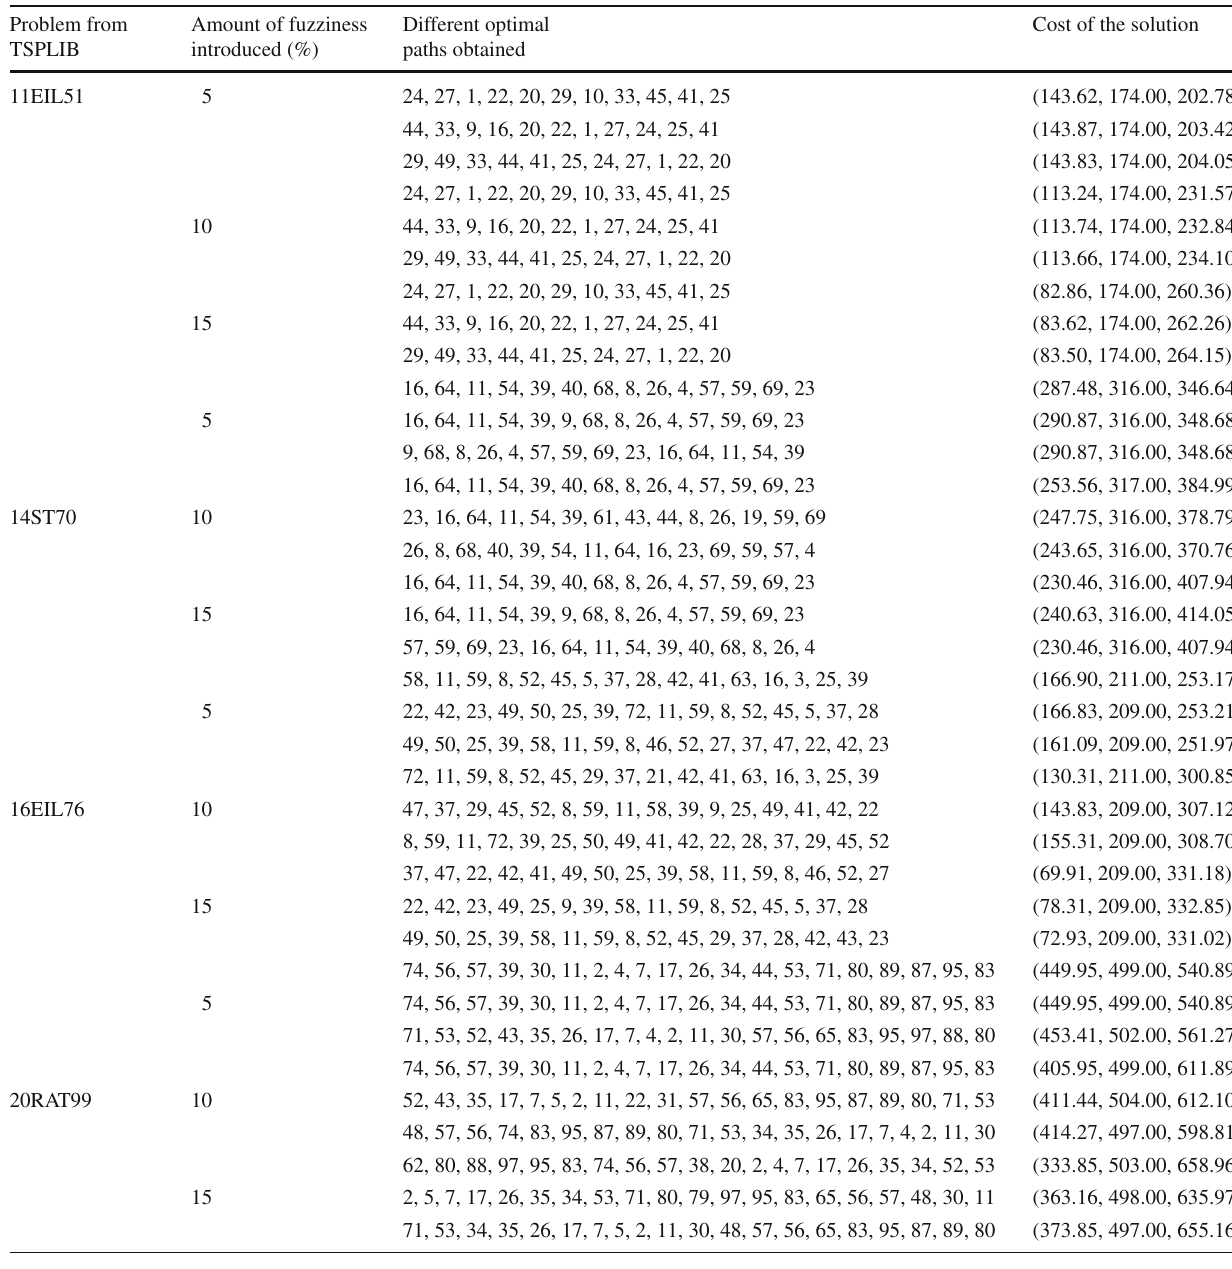
Table 4 Different paths obtained for different fuzzy TSPs generated from some problems of TSPLIB by the proposed algorithm Problem from Amount of fuzziness Different optimal TSPLIB introduced (%) paths